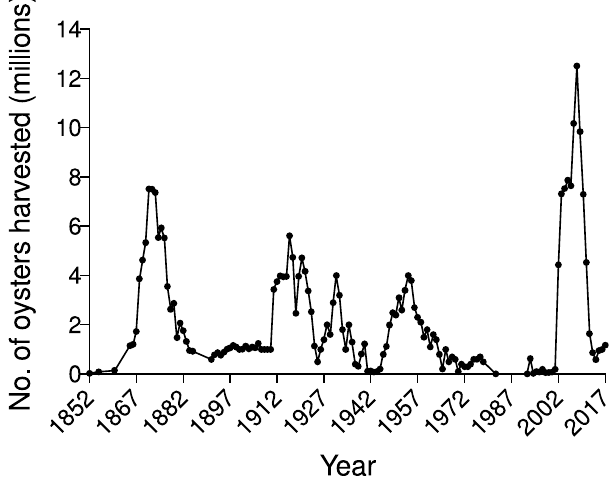
Fig. 2. Harvest of European fl at oysters ( Ostrea edulis ) in numbers (millions) from the Limfjorden from 1852 to